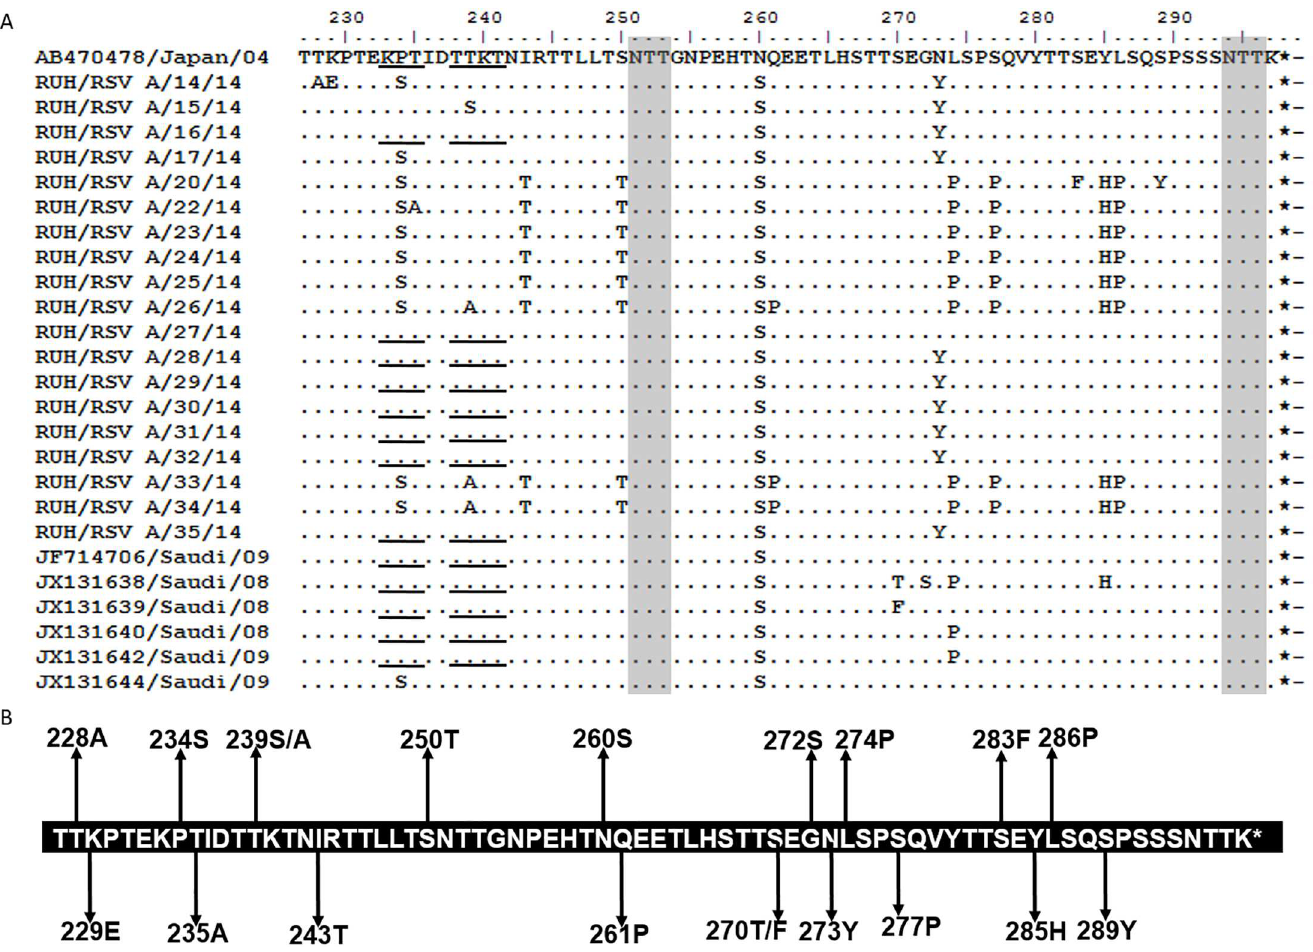
PLOS ONE | DOI:10.1371/journal.pone.0166145 November11,